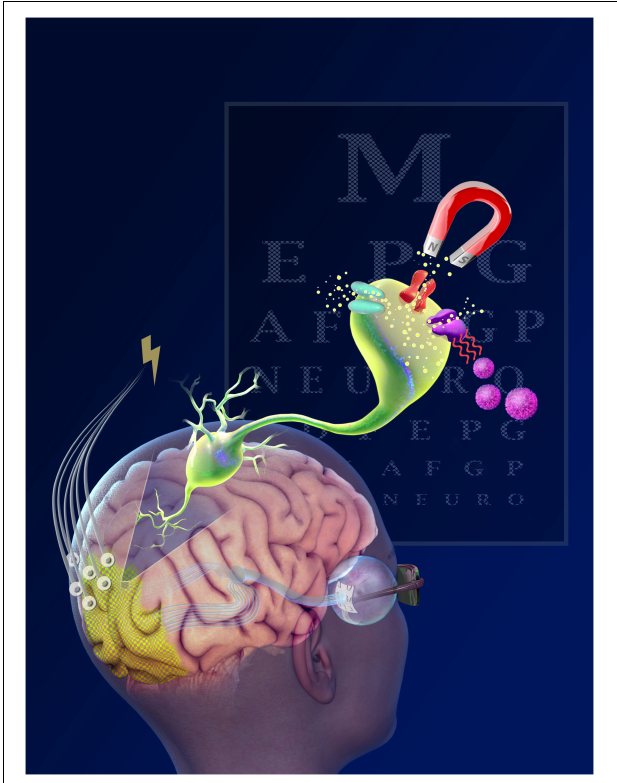
FIGURE 1 | Electrical, light and magnetic stimulation for interfacing visual